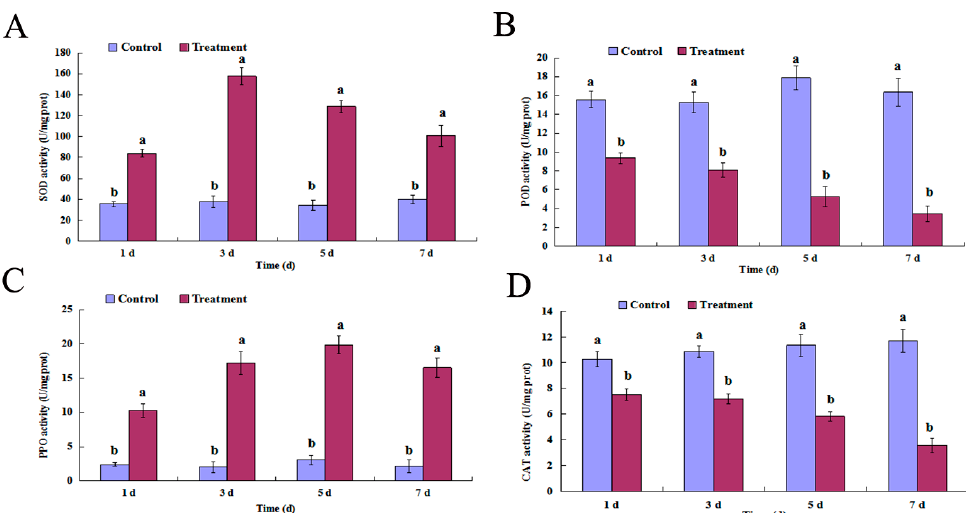
Figure 4. Detection of ( A ) superoxide dismutase (SOD); ( B ) peroxidase (POD); ( C ) polyphenol oxidase (PPO); ( D ) and catalase (CAT) activities of cucumber leaves treated with cuminic acid at 500 μ g/mL. Values are means and standard errors; a, b mean values followed by different letter within the same day were significantly different in LSD tests at p = 0.05.